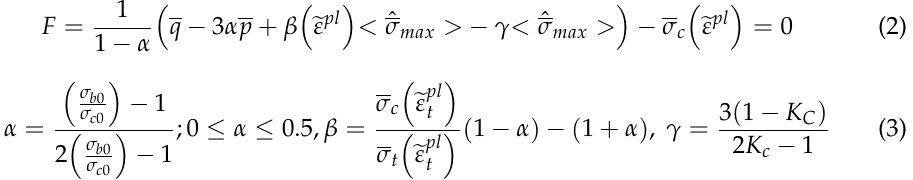
Figure 9. Constitutive curves for uniaxial damage in: ( a ) tension; ( b ) compression.